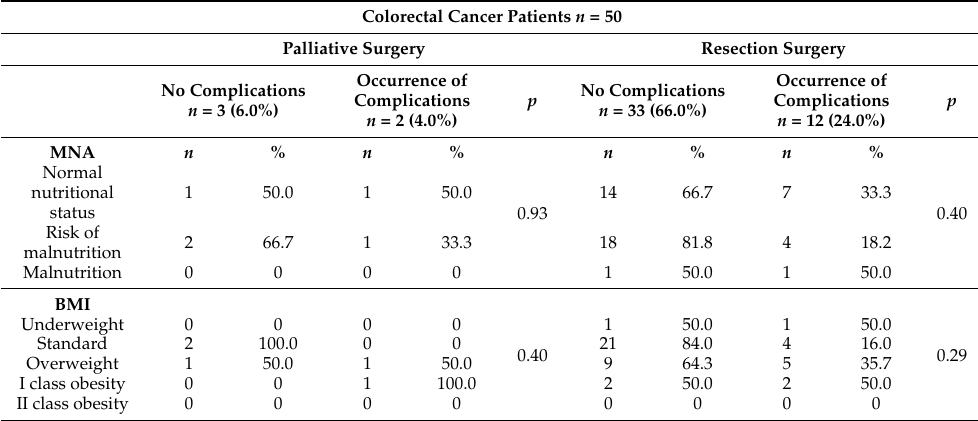
Table 4. Nutritional status of patients with colorectal cancer before surgery and the incidence of postoperative complications considering the type of surgery. Colorectal Cancer Patients n = 50 Palliative